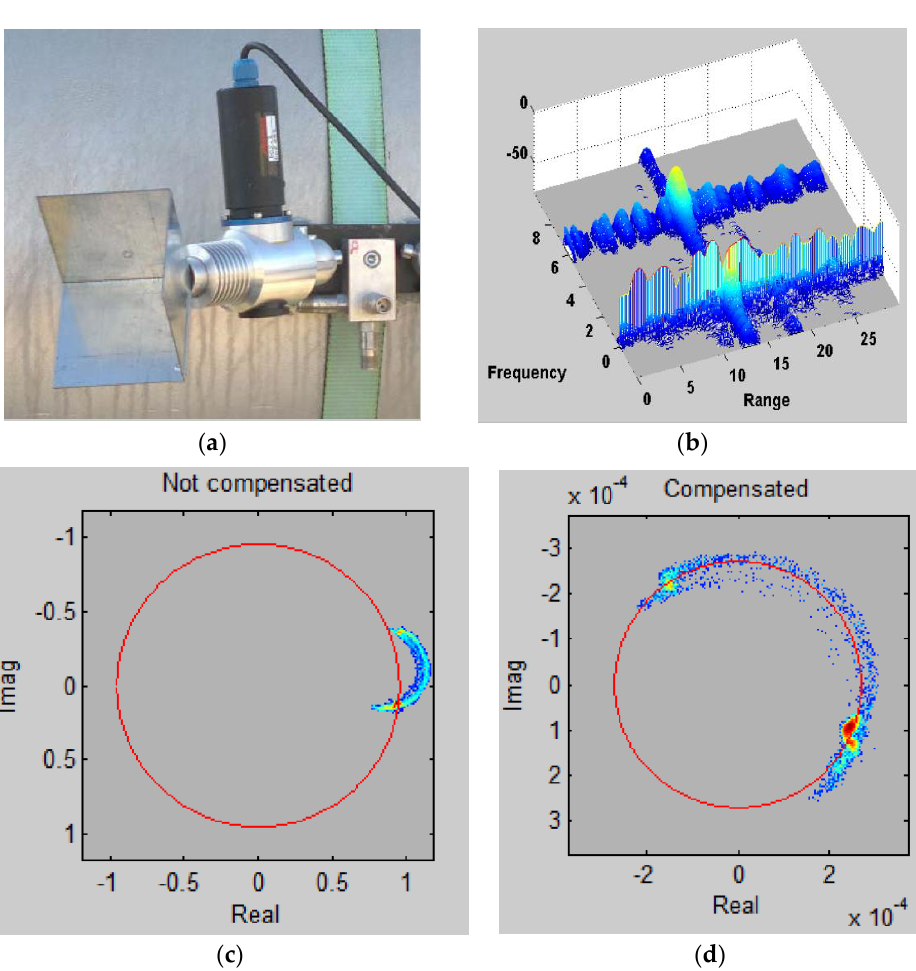
Figure 7. ( a ) Motorized target. ( b ) Measured vibration field in the range – Doppler domain. ( c ) Complex Scatter Plot (CSP) diagrams measured before and ( d ) after the proposed fixed clutter removal.